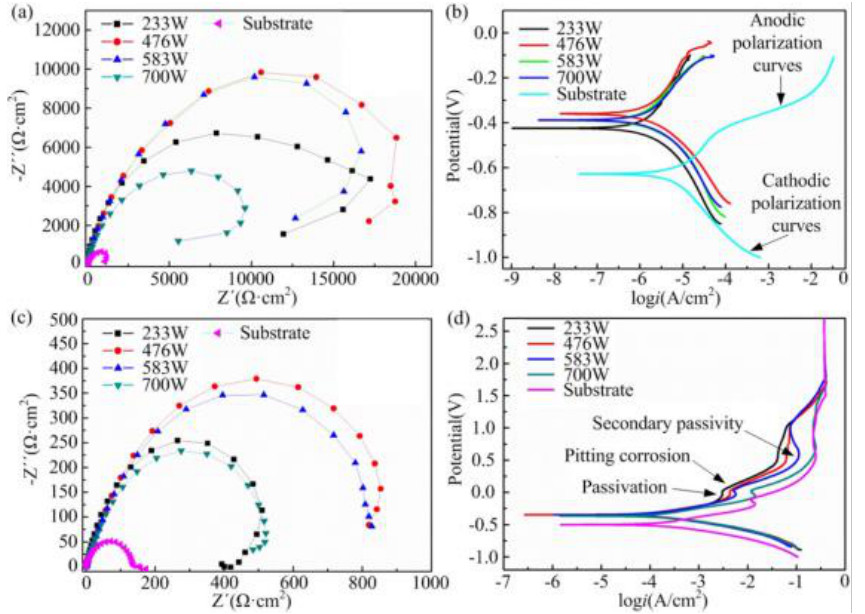
Figure 5. The electrochemistry test result of the substrate and coatings [ 56 ] . ( a ) EIS diagram in 3.5 wt.% NaCl solution, ( b ) polarization curves in 3.5 wt.% NaCl solution, ( c ) EIS diagram in 1 mol/L HCl solution, ( d ) polarization curves in 1 mol/L HCl solution. Copyright 2018 Elsevier.